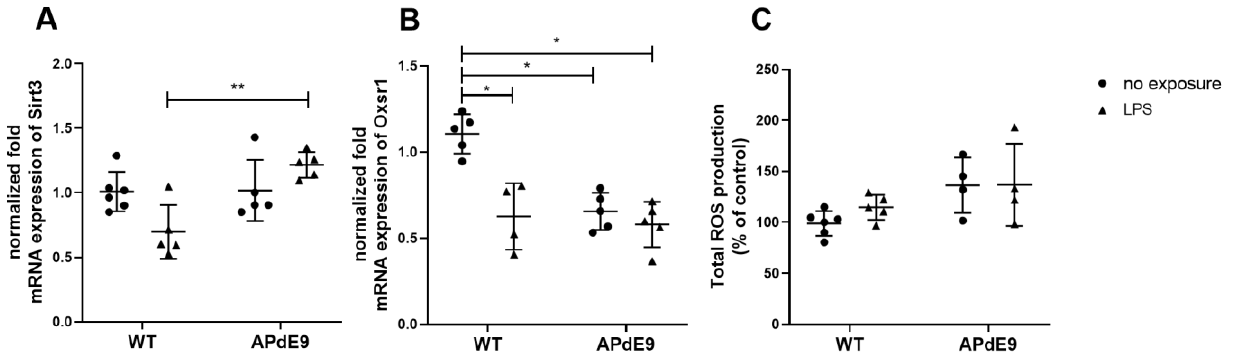
Figure 4. Comparison of normalized fold mRNA expression of oxidative stress markers sirtuin-3 (Sirt3) ( A ) and oxidative stress responsive kinase 1 (Oxsr1) ( B ) and the production of reactive oxygen species (ROS) expressed as % to control ( C ) in the cerebral cortical tissue in saline-treated female wild-type (WT) control mice vs. female WT mice treated with LPS, and female APdE9 mice treated either with saline or LPS. The line represents group mean and whiskers—the SD ( n = 4–6 per group). differences are marked with asterisks, where * indicates p < 0.05, ** p <